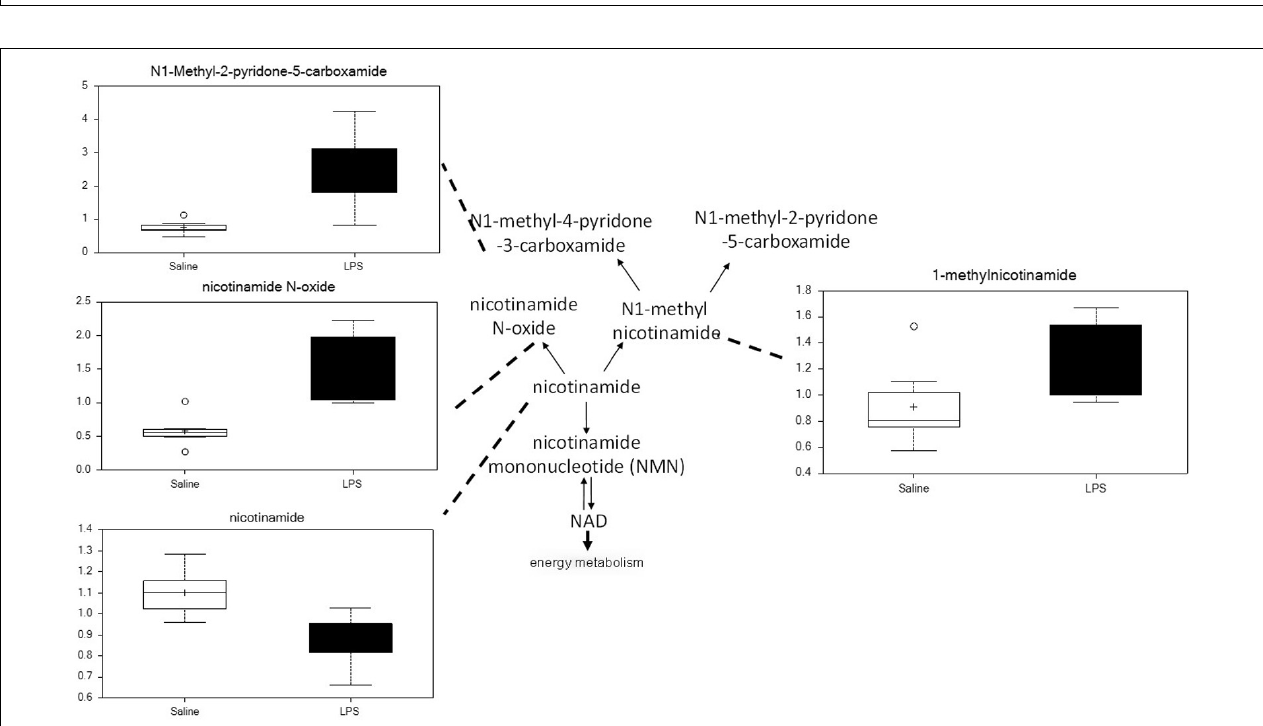
FIGURE 8 | Maternal LPS increases nicotinamide degradation in placenta. Box plots of nicotinamide metabolites in LPS (black boxes) and control (white boxes). N = 8 both groups.